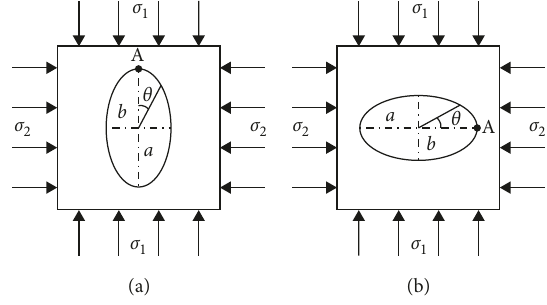
Figure 10: Microfracture damage model.